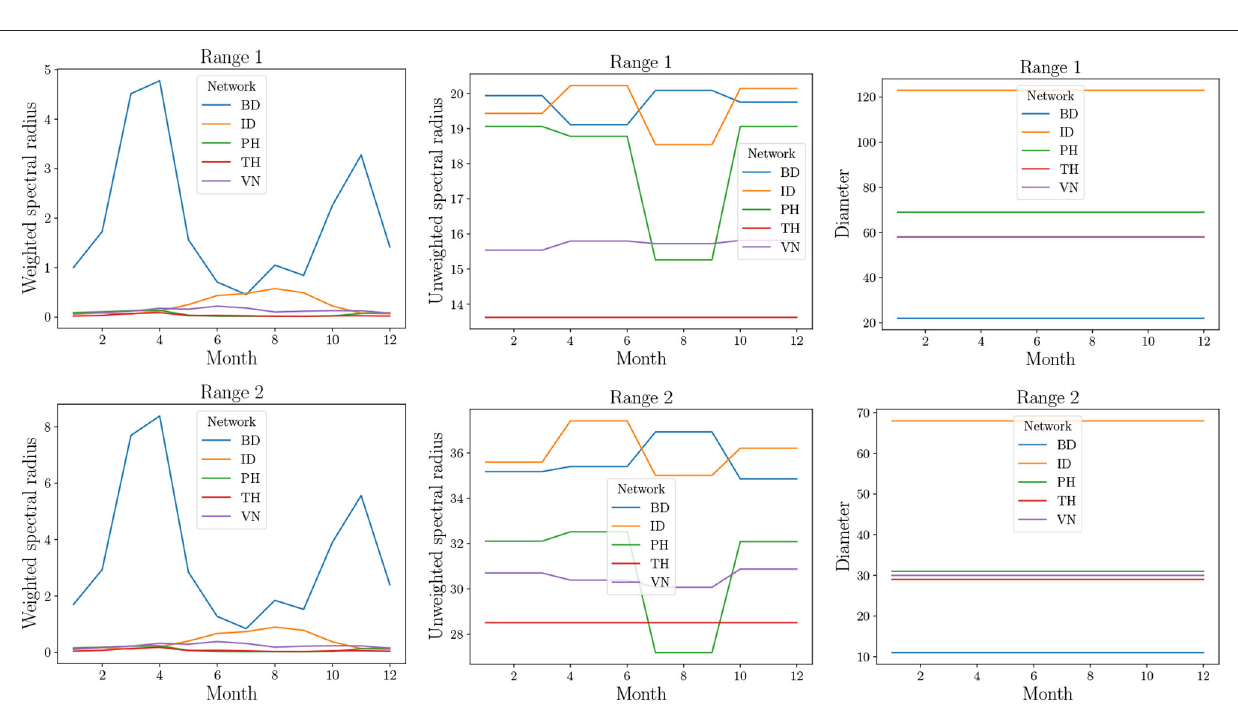
FIGURE 10 | Structural properties of real-world datasets from Table 2 . Since these are temporal networks, the properties are plotted for 12 snapshots, each representing a month of the year by natural order. In the top right plot, TH overlaps with